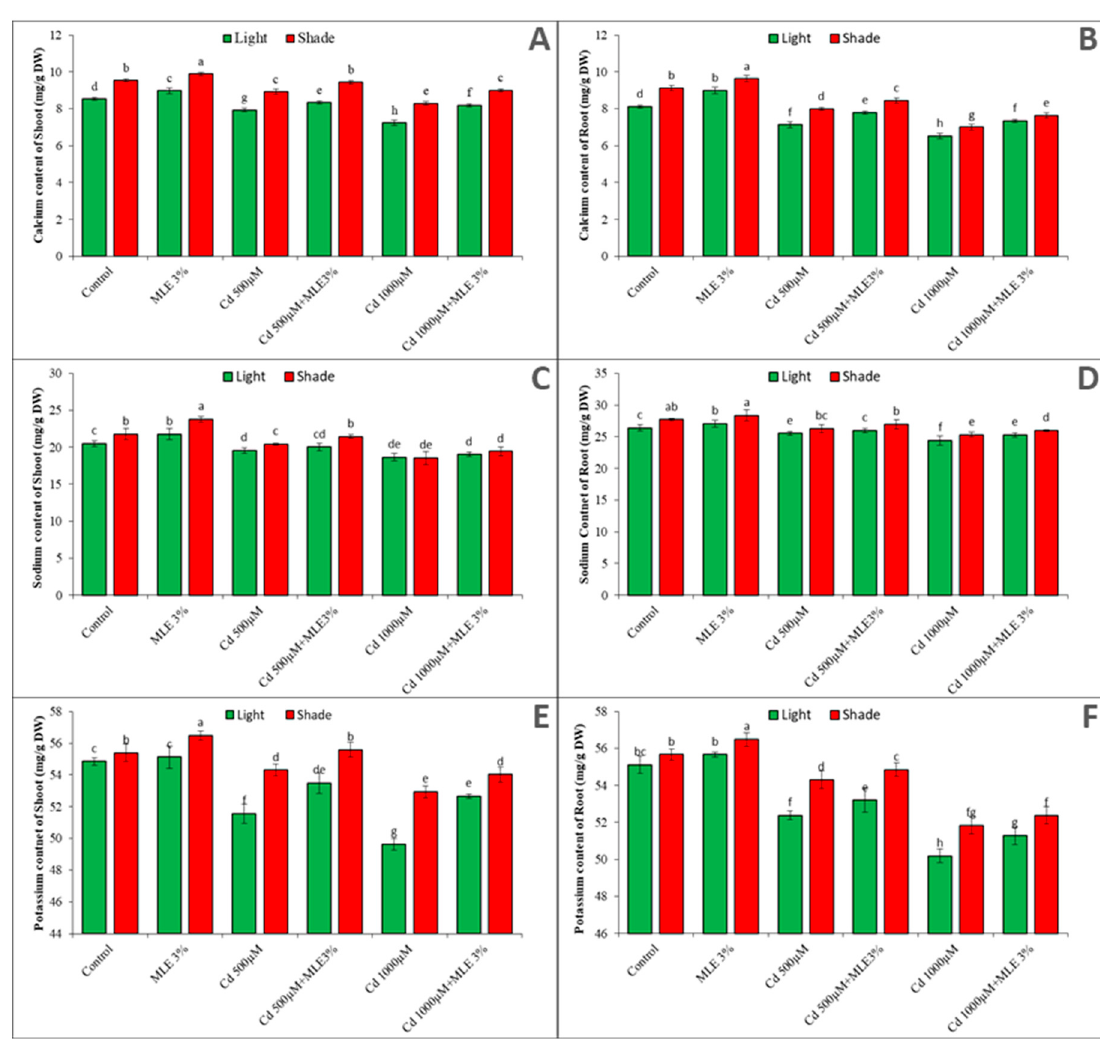
Figure 6. Effect of MLE application on mineral constitutes of plant ( A ) calcium content of shoot ( B ) calcium content of root ( C ) sodium content of shoot ( D ) sodium content of root ( E ) potassium content of shoot and ( F ) potassium content of root, with and without Cd stress under light and subdue light. Different letters above bars represents significant differences ( p < 0.05) at each measured point. Values represent mean ± SE of three replicates of each treatment.